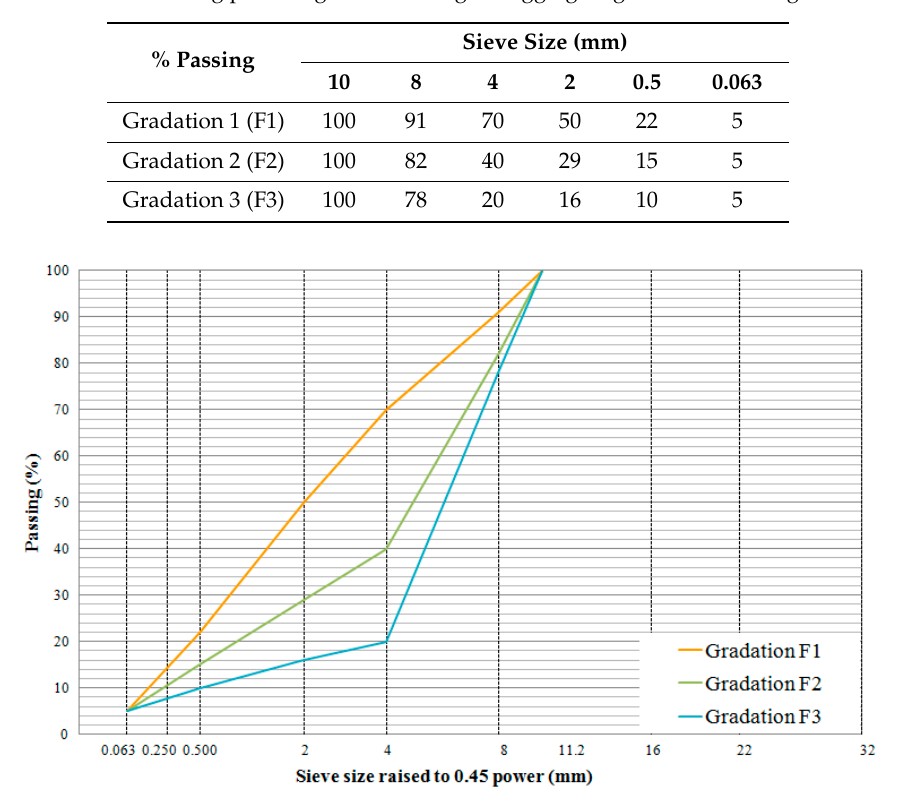
Figure 1. Aggregate gradation for stage 1.